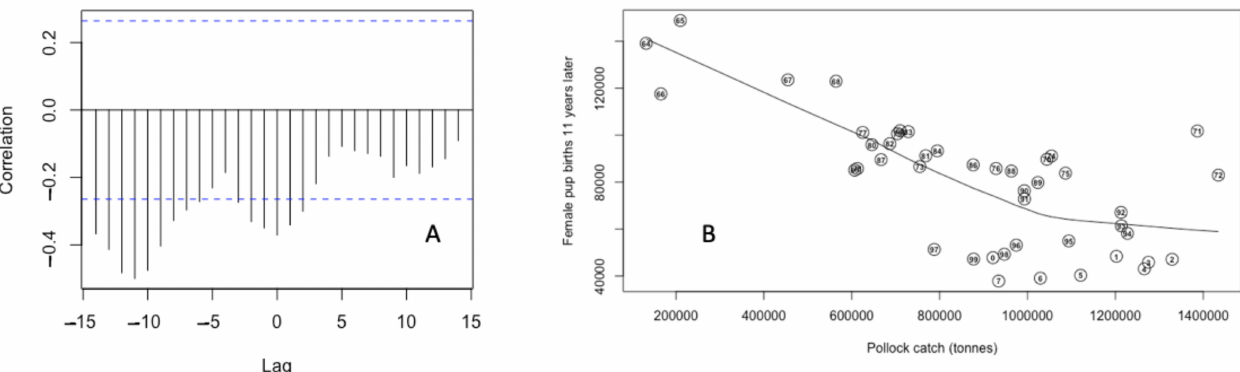
Figure 4. ( A ) Cross-correlations between catches of pollock at different lags within our Pribilof fur seal foraging area, and female northern fur seal pup births on St. Paul Island from 1964 through 2018. Pollock catch leads pup births and is inversely related to female pup births, with a peak correlation at − 11 years. ( B ) St. Paul fur seal pup births as a function of pollock harvest 11 years earlier. The line in B is a LOWESS smoothing curve. Much of the appearance of a negative correlation comes from the three data points from a period of very low harvests of pollock in the 1960s, which are clustered in the upper left corner of the graph. The two-digit numbers used for plotting represent the years of the pollock catch in the 1990s. The one-digit codes indicate the year in the